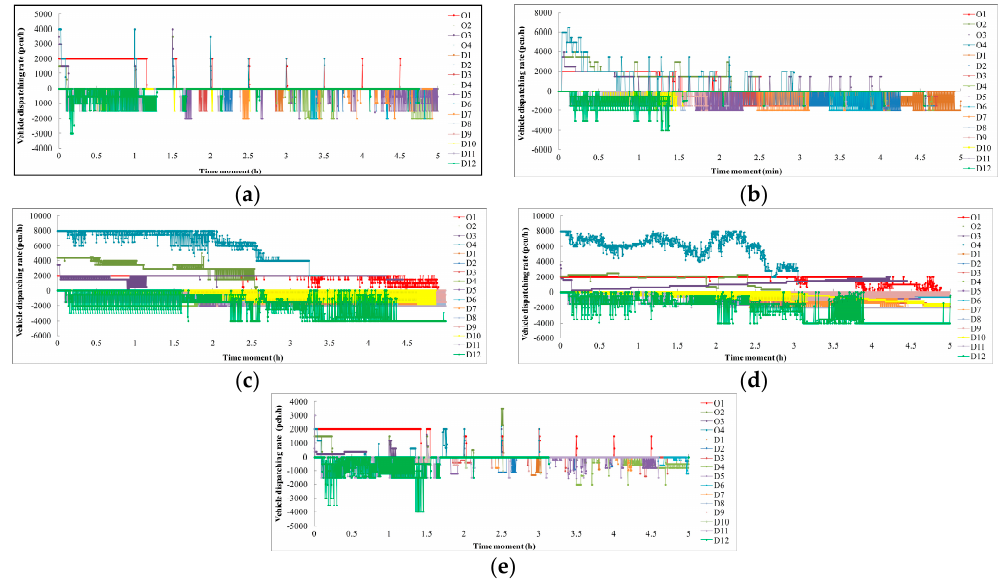
Figure 9. The utilized road in the emergency network.